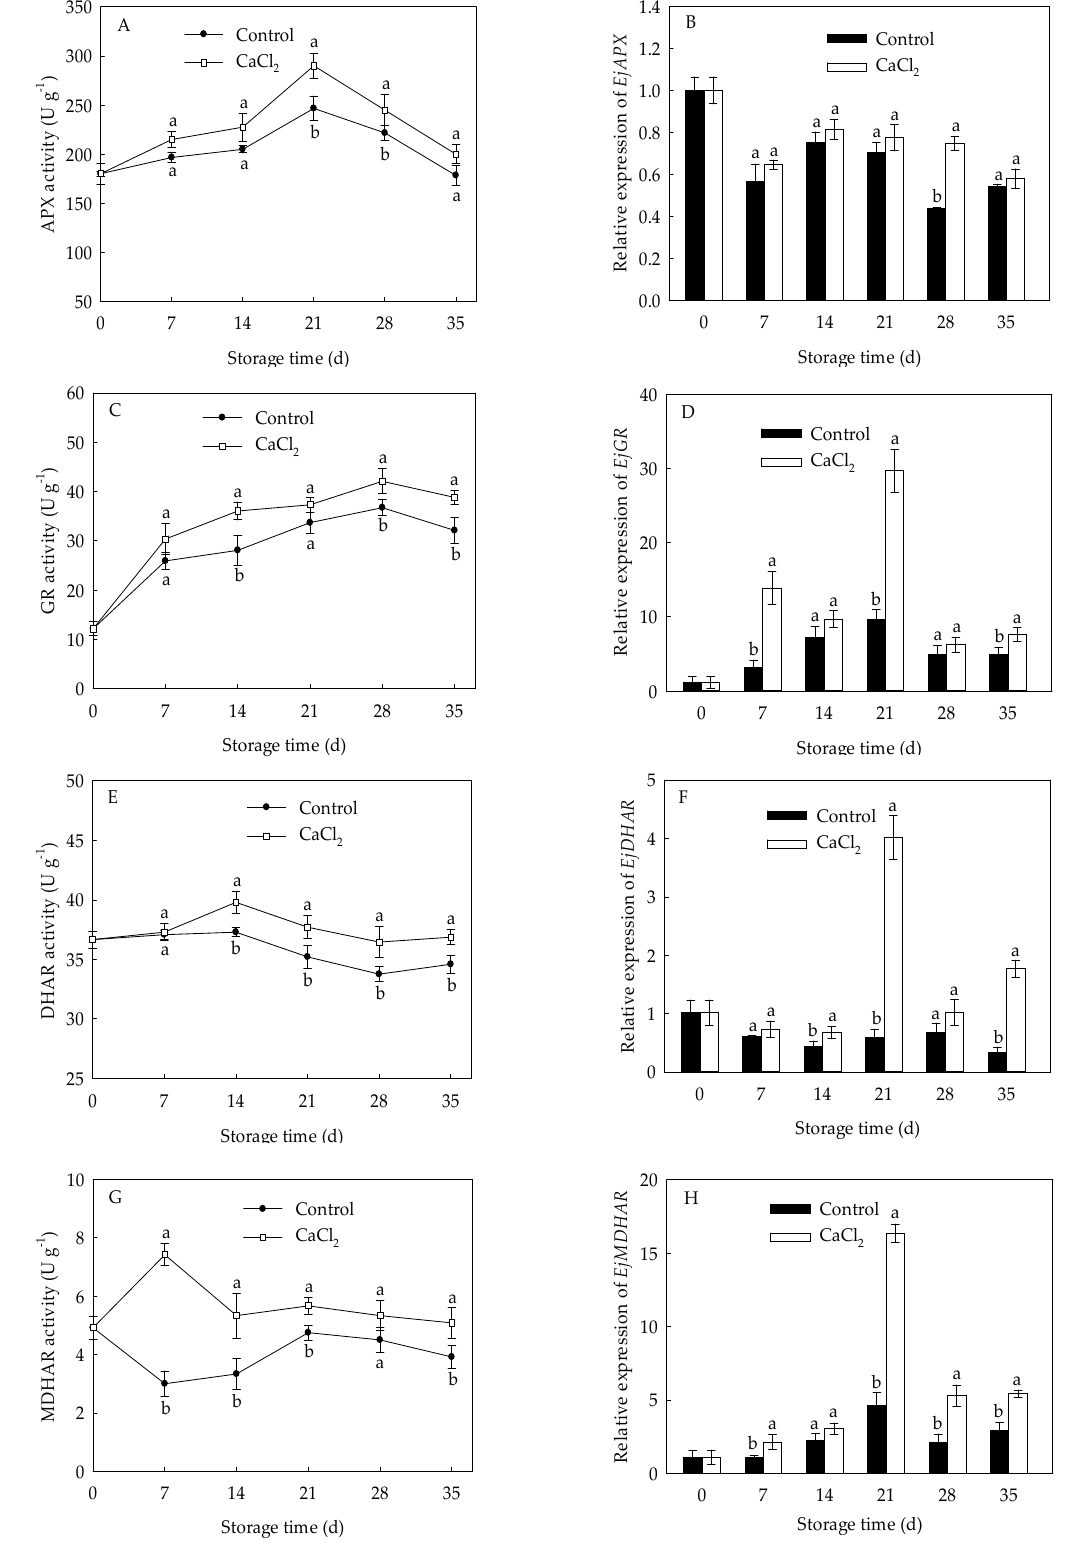
Figure 6. APX activity ( A ), EjAPX expression ( B ), GR activity ( C ), EjGR expression ( D ), DHAR activity ( E ), EjDHAR expression ( F ), MDHAR activity ( G ), and EjMDHAR expression ( H ) in loquat fruit stored at 1 °C after treatment with 1% CaCl 2 or water (control). Vertical bars indicate the SE of mean ( n = 3). The symbols a and b represent a significant difference in the two treatments ( p < 0.05).